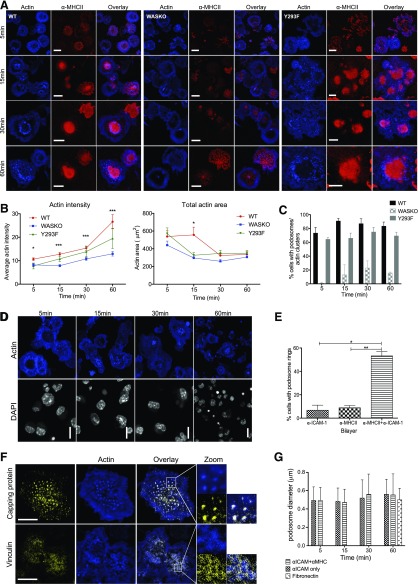
Novel actin organization at the DC synapse.(A) WT, WASKO, and Y293F DCs interacting with an α-MHC II-Cy5 (red) and α-ICAM-1 bilayer were fixed and stained with phalloidin (blue). Original scale bars, 5 μm. (B) The polymerized actin was stained with phalloidin, and fluorescent intensity at the contact site as well as total actin area was quantified at the 4 time points. A minimum of 100 cells was analyzed in 4 experiments; means and sem are plotted. For actin intensity: *5 min: P(WT + WASKO) = 0.0113, P(WT + Y293F) = 0.0428; ***15 min: P(WT + WASKO) = 0.0005, P(WASKO + Y293F) = 0.0256; ***30 min: P(WT + WASKO) = 0.0007; ***60 min: P(WT + WASKO) = 0.0009. For total actin area: *15 min: P(WT + WASKO) = 0.0346. (C) Percentage of WT, WASKO, and Y293F DCs forming podosomes on an α-MHC II and α-ICAM-1 bilayer. A minimum of 400 cells was analyzed at each time point. “Actin clusters” are irregular, high-intensity actin structures, similar to those in WASKO cells at 30 and 60 min (A). (D) WT DC contacting an α-ICAM-1-only bilayer. Position of cells is depicted by DAPI staining (white). Phalloidin staining (blue) shows podosome rosettes. (E) The proportion of WT cells forming rings of podosomes in the 3 bilayer conditions is quantified. Means and sem from 3 experiments are shown; a minimum of 300 cells was analyzed. *P = 0.0241, **P = 0.0073 (F) WT DC contacting an α-MHC II-Cy5 and α-ICAM-1 bilayer, showing actin-rich podosomes (blue) and immunofluorescent staining (yellow): capping protein (F-actin capping protein, α subunit; upper), vinculin (lower). Colocalization of F-actin capping protein and actin produces a white overlay; 36 WT DCs were analyzed to calculate colocalization. Pearson correlation coefficient = 0.442 ± 0.14; Mander’s overlap coefficient = 0.777 ± 0.04. Original scale bars, 5 μm. A 3× zoom is shown to the right. (G) DCs were seeded on 2 different bilayers and on fibronectin (50 μg/ml) and fixed at set intervals. Diameter of the podosome actin cores was measured in ImageJ; >100 podosomes were measured for each condition. Synapse podosomes did not change significantly over time and showed a similar size to those formed on the ventral side of cells adhering to fibronectin.